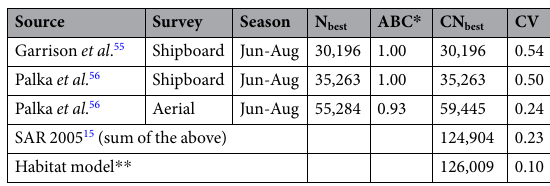
Table 4. Robustness validation results of the common dolphin model. Common dolphin abundance estimates for 2004 by platform and the abundance estimate derived from the habitat model which includes the availability bias correction. N best = Abundance estimate; ABC = Availability bias correction factor; CN best = Abundance estimate corrected for availability bias; CV = Coefficient of variation. * Palka et al . 14 . ** 2010–2013 model definition, with June to August 2004 sea surface temperature